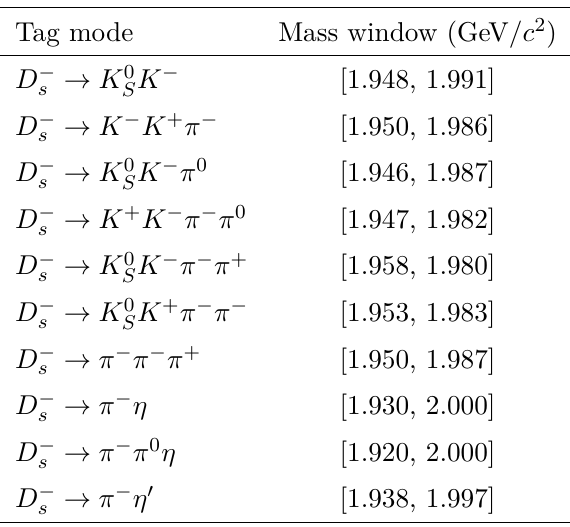
Table 3 . Requirements on M tag for the ten tag